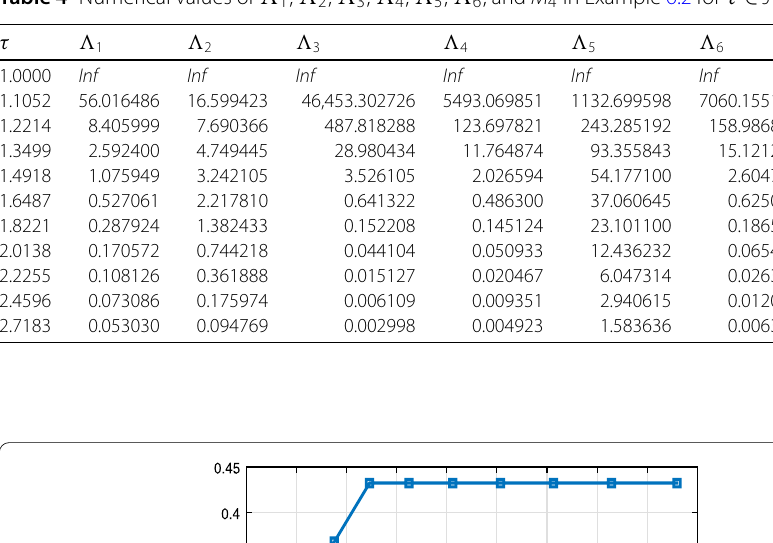
Table 4 Numerical values of (cid:19) 1 , (cid:19) 2 , (cid:19) 3 , (cid:19) 4 , (cid:19) 5 , (cid:19) 6 , and ˘ M 4 in Example 6.2 for τ ∈ J